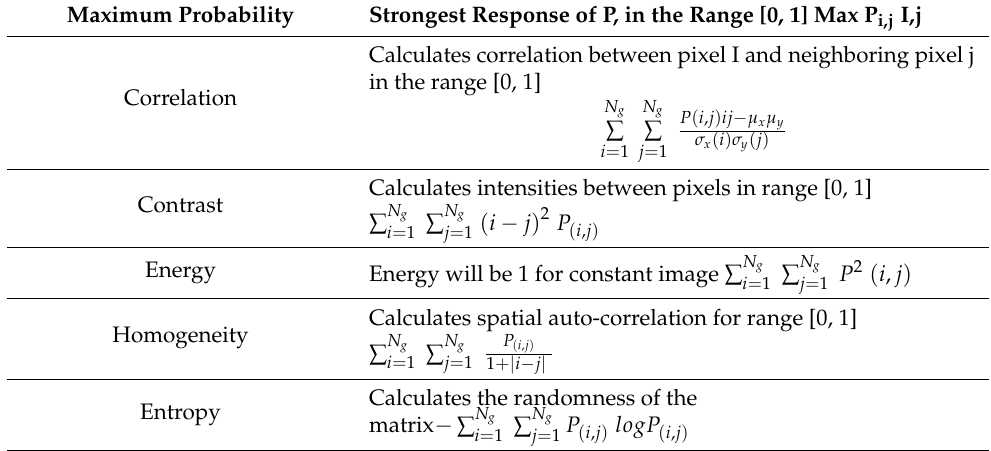
Table 2. Harlick features of